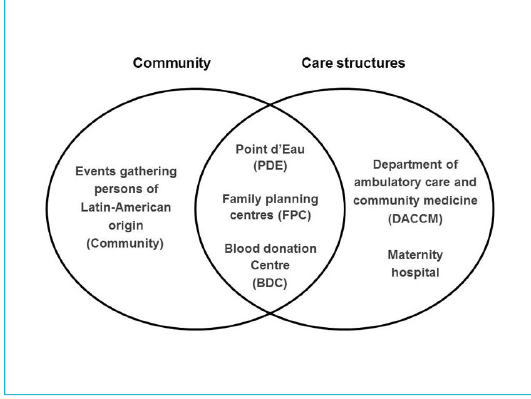
Figure 1: Screening places for Chagas disease. The Depart- ment of Ambulatory Care and Community Medicine (DACCM) serves as an outpatient clinic for the University Hospital of Lau- sanne; the Point d’Eau (PDE) is an urban, low-level healthcare centre attended mainly by undocumented immigrants; the family planning centres (FPC) provide sexual counselling and related ac- tivities.